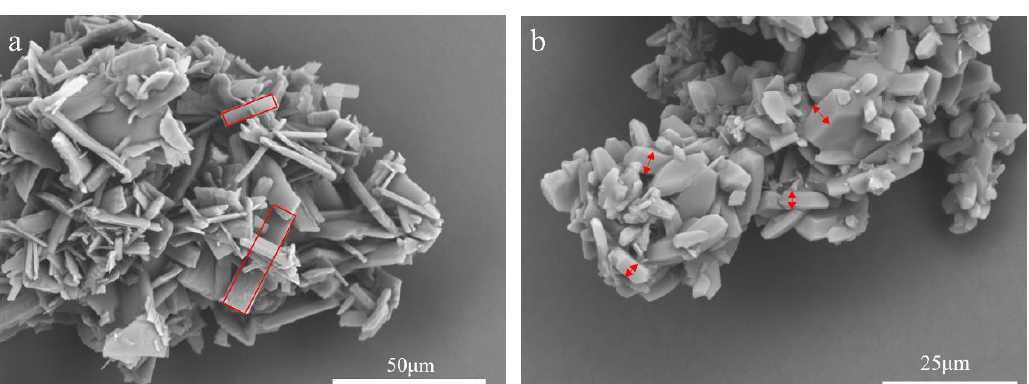
Figure 11. ( a ) The lamellar pyriproxyfen crystal obtained in ethanol solution; ( b ) the shuttle pyriproxyfen crystal obtained in n-heptane solution. The red square frame highlights the lamellar crystal of pyriproxyfen. The red line in b shows the thickness of the fusiform pyriproxyfen crystal. For the (102) crystal plane, the E int value of the interaction strength of the ethanol